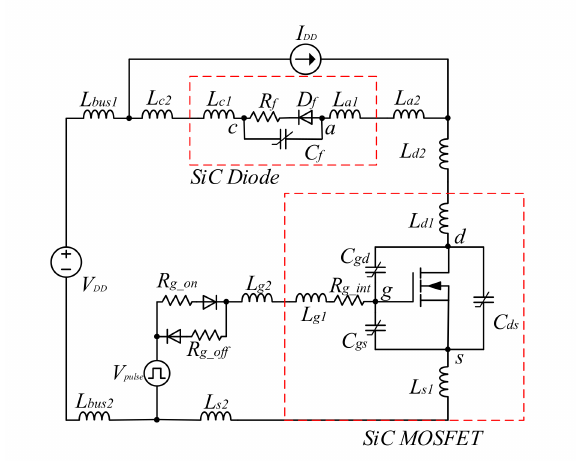
Figure 3. Analytical model of the double-pulse-test circuit considering parasitic